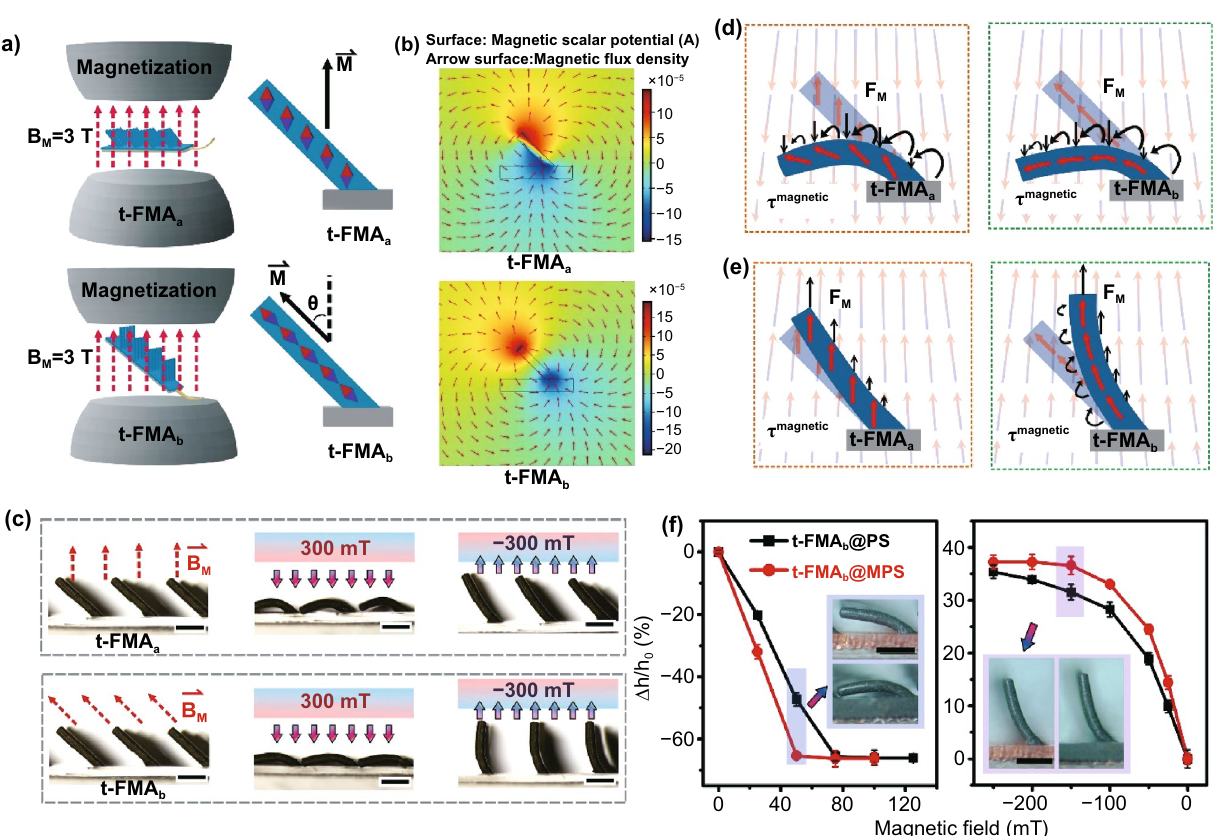
Fig. 2 a Magnetizing process illustration of t-FMA a and t-FMA b . b Simulation results of magnetic field distribution of t-FMA a and t-FMA b . c Actuated deformation of t-FMA a and t-FMA b under the positive and negative magnetic fields with a magnitude of ~ 300 mT. Scale bars: 1 mm. d‑e Mechanism of the bending actuation of t-FMA a and t-FMA b under positive ( d ) and negative magnetic field ( e ). F M and τ magnetic represent the magnetic force and magnetic torque, respectively. f Actuated deformation of t-FMA b @PS with PDMS substrate and t-FMA b @MPS with NdFeB/PDMS substrate under magnetic fields. Scale bars: 1 mm. h and h 0 represent the resultant and initial vertical distance from pillar top to the substrate,